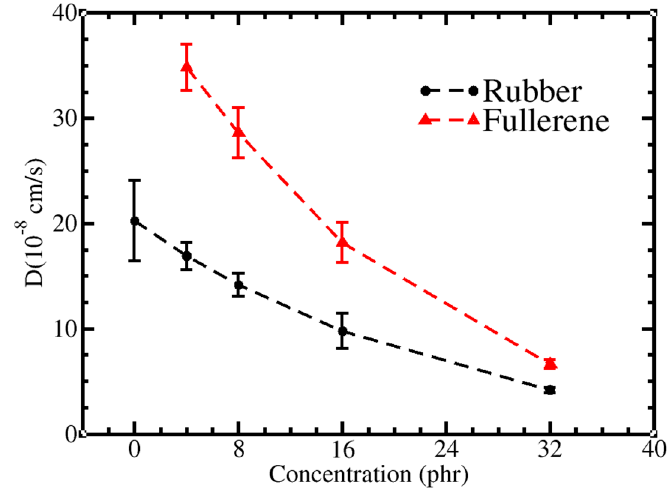
Figure 4. Black line: the diffusion coefficients of rubber in melt (0 phr) and composites (phr ≠ 0). Red line: the diffusion coefficients of C 60 in composites as a function of C 60 concentration.